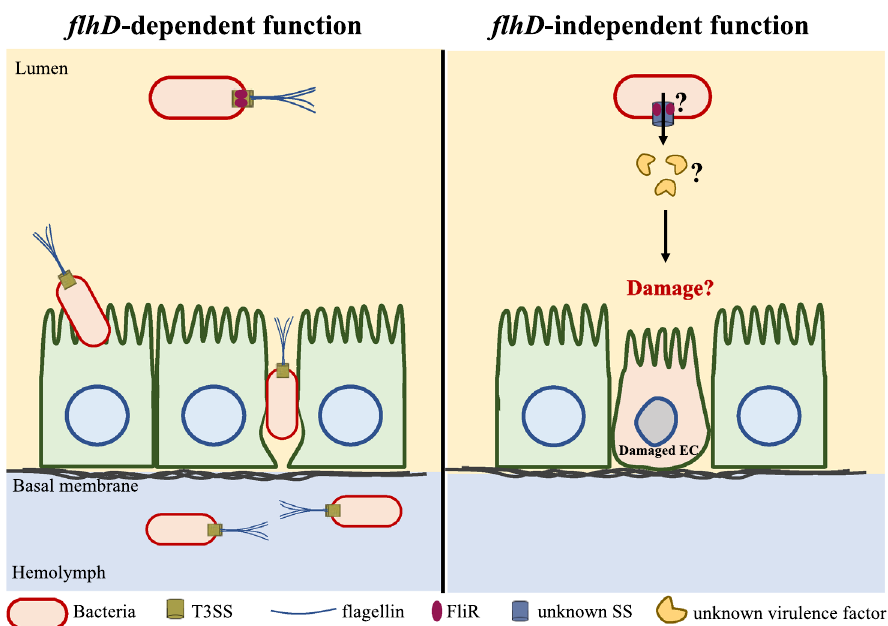
Figure 4. An flhD- independent function of fliR in the Drosophila intestinal infection model. (Left) The flhD- dependent function of fliR is restricted to its role in the flagellum formation. The flagellum is required for S. marcescens to traverse the epithelial barrier to reach the hemolymph. (Right) fliR acquired a function in the virulence of the bacteria independently from its role in the flagellum. fliR may be needed for the assembly of an flhD- independent secretory apparatus that would release virulence factors that may damage the intestinal